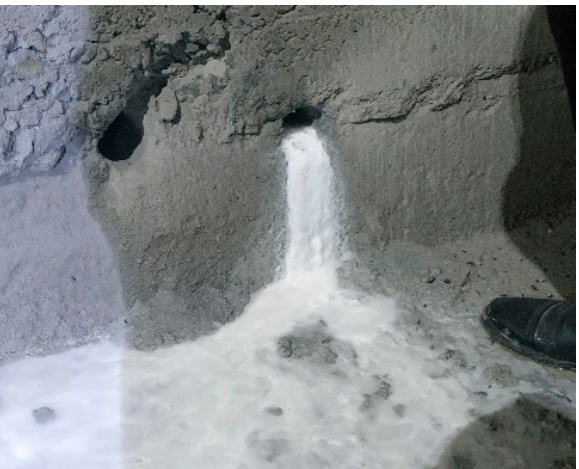
Figure 1. Crystallization and clogging in drainage pipes in the Baoligang Tunnel of the Emeishan- Hanyuan Expressway.